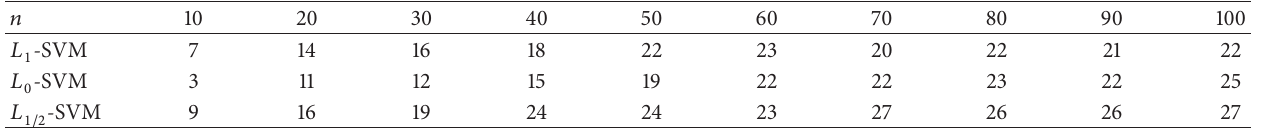
Table 2: Frequency of the most important features ( 𝑥 3 ,𝑥 6 ) ranked on top 2 in 30 runs.